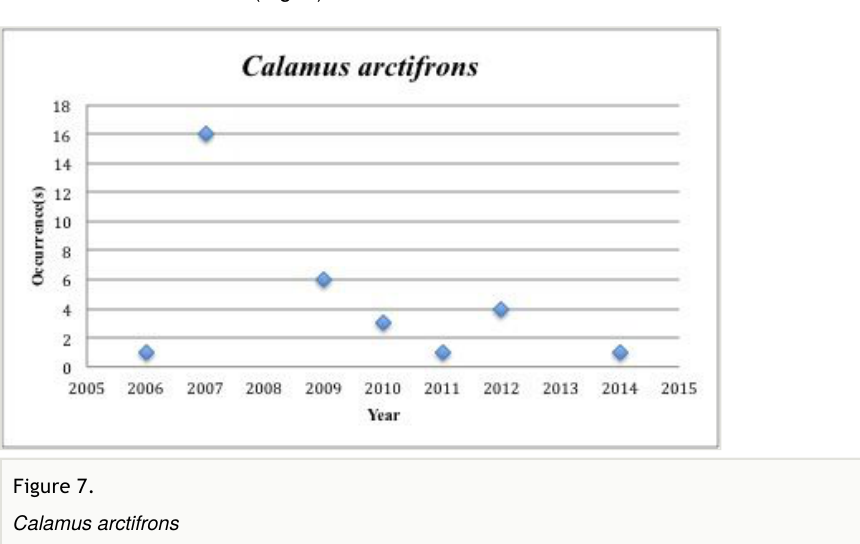
Figure 7. Calamus